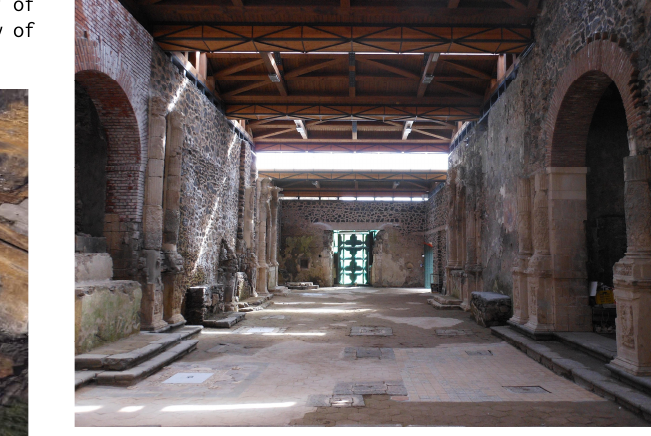
Figure 5. Interior of the church